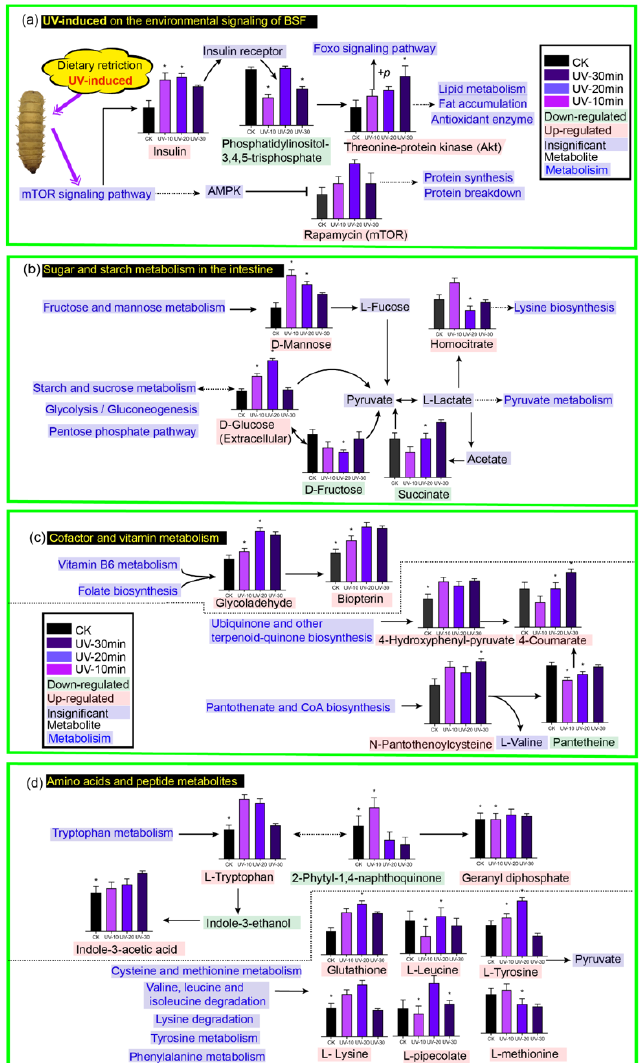
Figure 5. Effect of UV stimulation on metabolic pathways of BSF ( a ) environmental signaling, ( b ) enhanced degradation of starch and sugars from food waste, ( c ) cofactors for functional component production, and ( d ) amino acid and peptide metabolism ( p < 0.05).